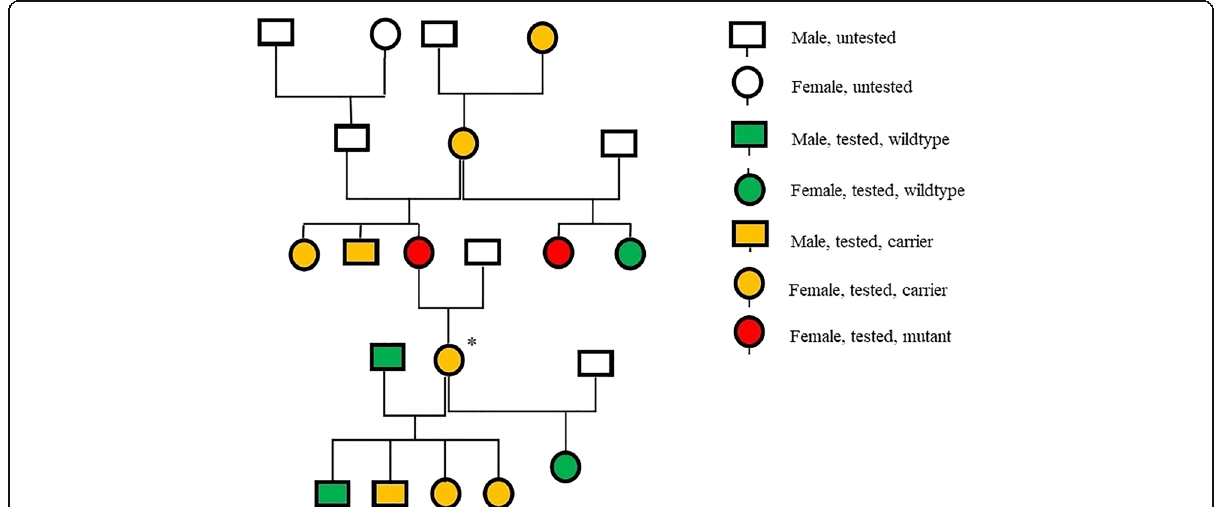
Fig. 3 Von Willebrand ’ s Disease segregation in the Dutch Shepherd Dog. Dutch Shepherd Dog pedigree following first identification (*) of a carrier of Von Willebrand ’ s Disease type I. This individual was a female long haired shepherd born in 2010.